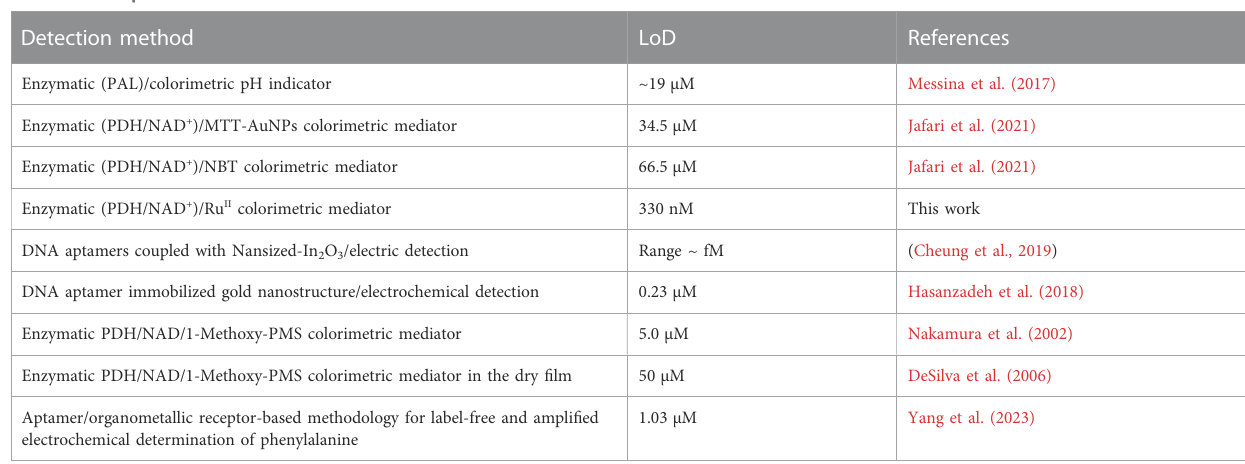
TABLE 1 A comparison of different methods for Phe